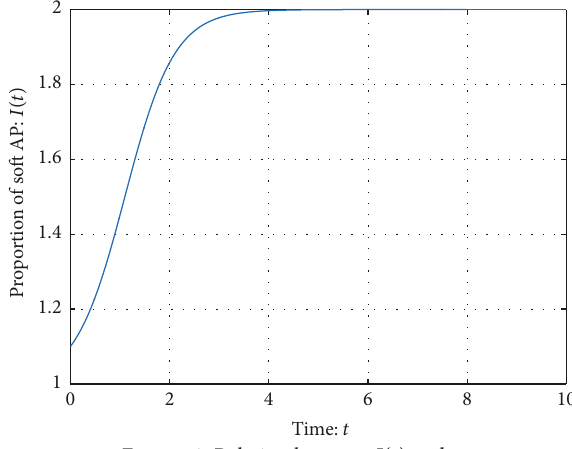
Figure 2: Relation between 𝐼(𝑡) and 𝑡 .